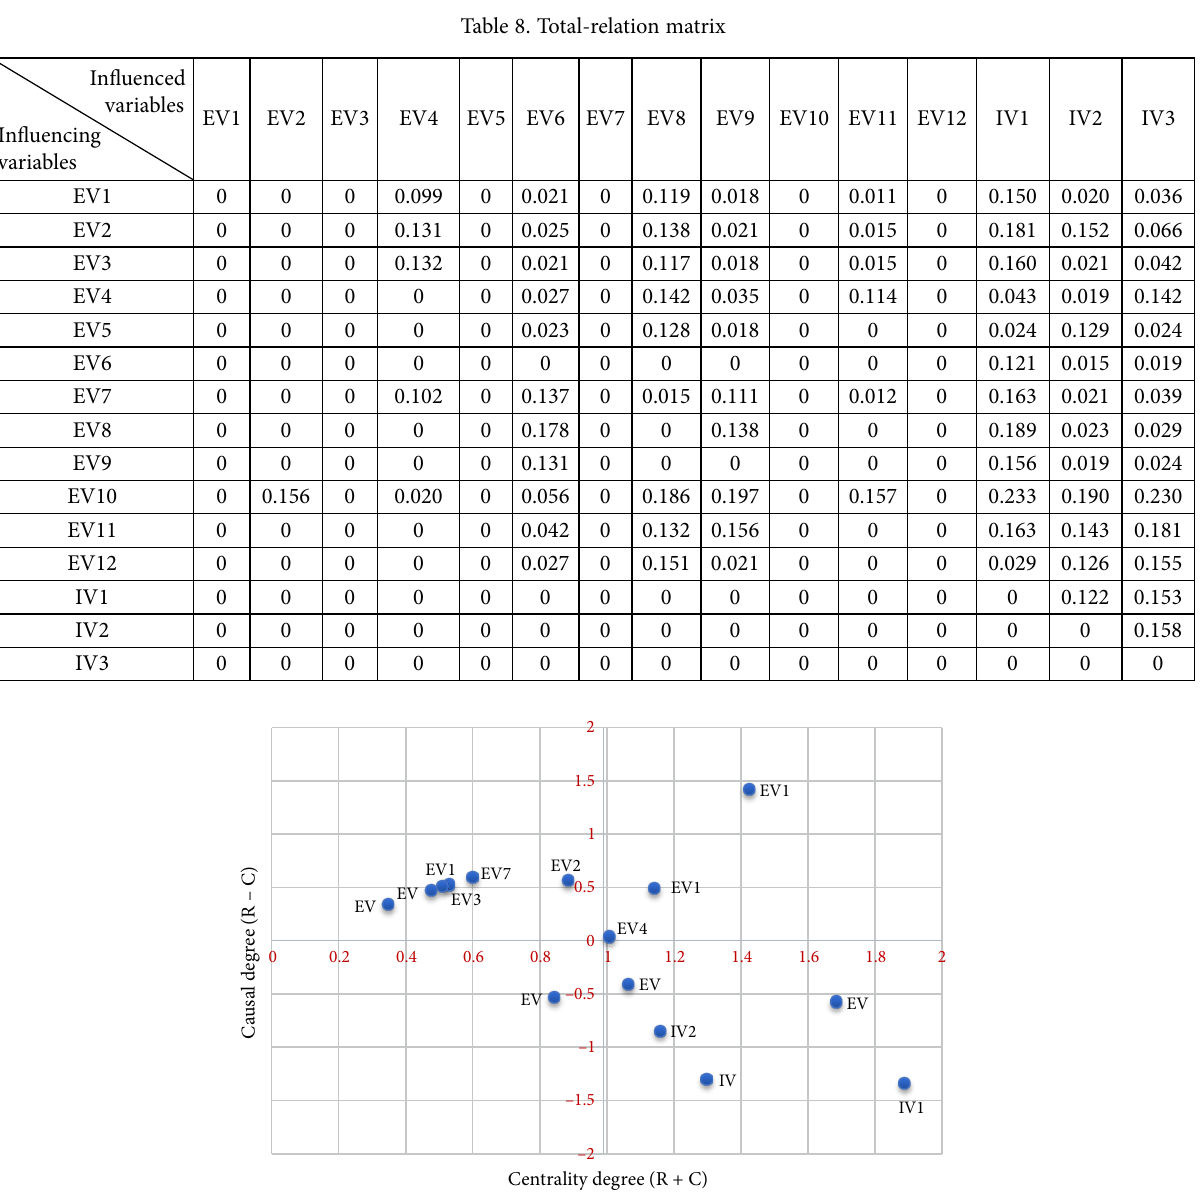
Figure 4. Scatter point diagram of centrality degrees and causal degrees of variables